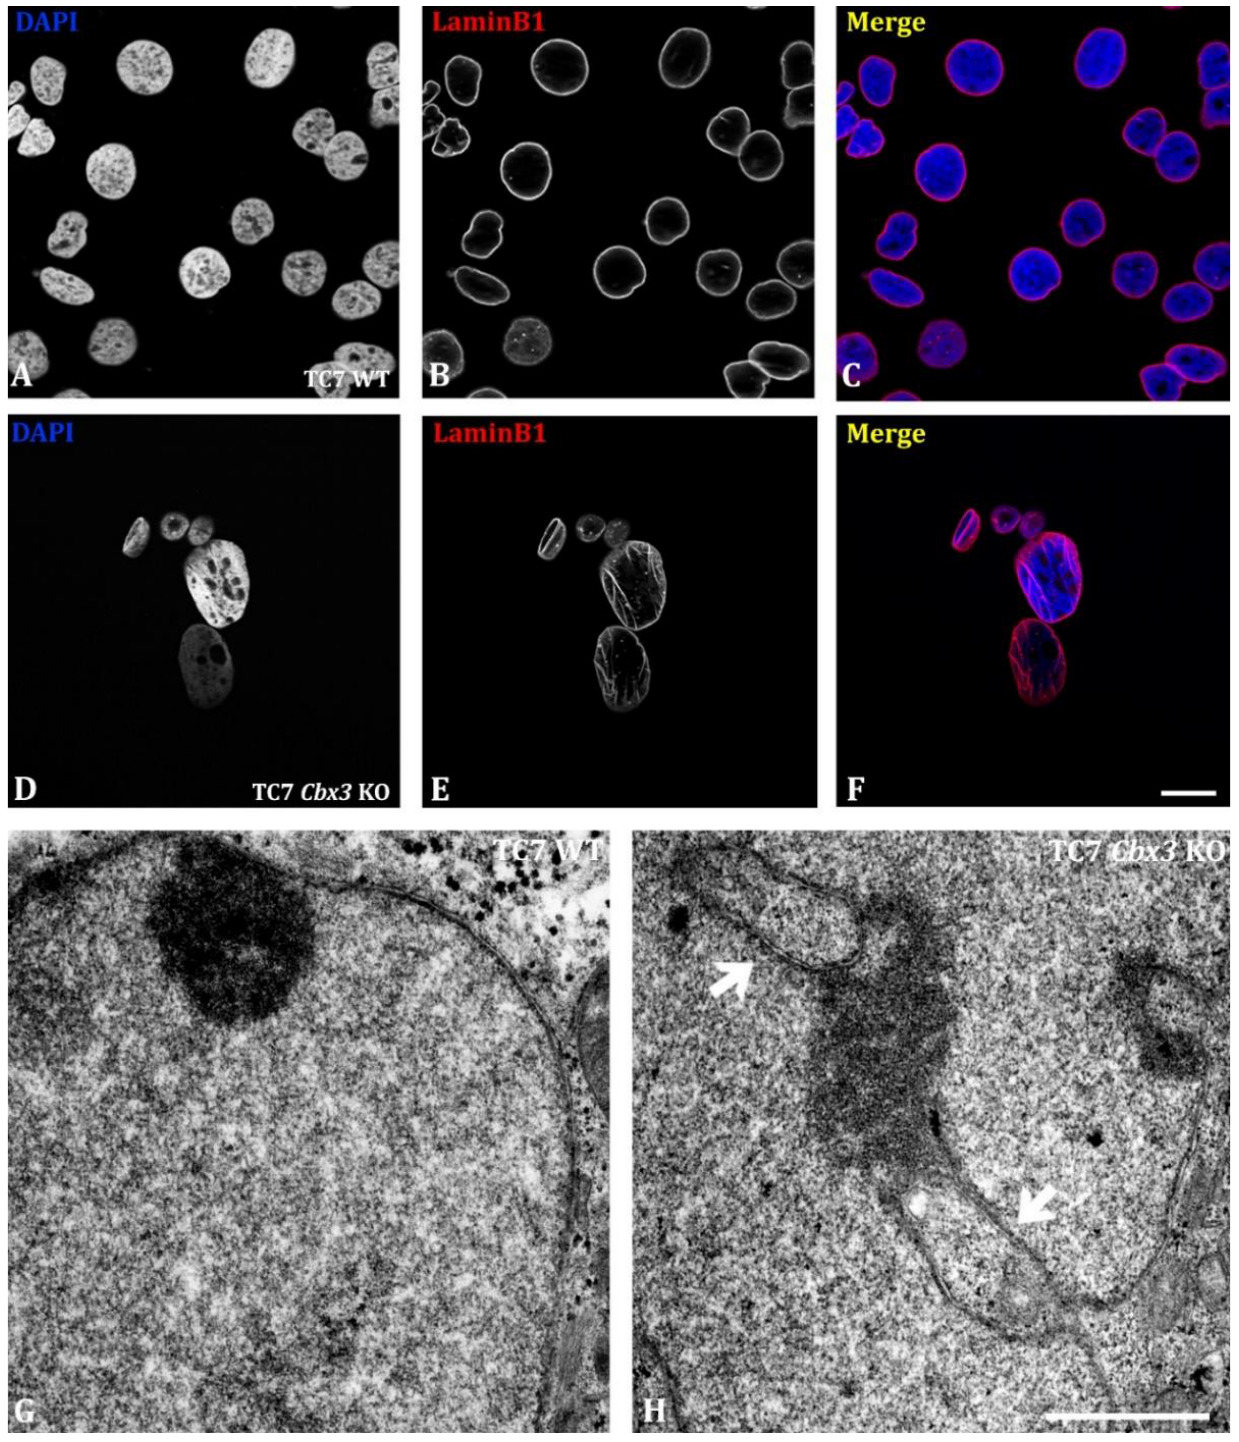
Figure 1. Alterations in the nuclear envelope in TC7 Cbx3 KO cells. ( A – F ) Immunofluorescence of the nuclear envelope-associated protein LaminB1: large alterations can be seen in cells lacking HP1γ ( D – F ), whereas no abnormalities are seen in WT cells ( A – C ); ( G , H ) TEM analysis of nuclear envelope alterations in TC7 WT ( G ) or Cbx3 KO ( H ) cells: double membrane inclusions can be observed in cells lacking HP1γ ( H, arrows). n = 5 clones analyzed per condition, 2 plates per clone. Scale bar: ( A – F ) 20 µm; (G,H) 1 µm.